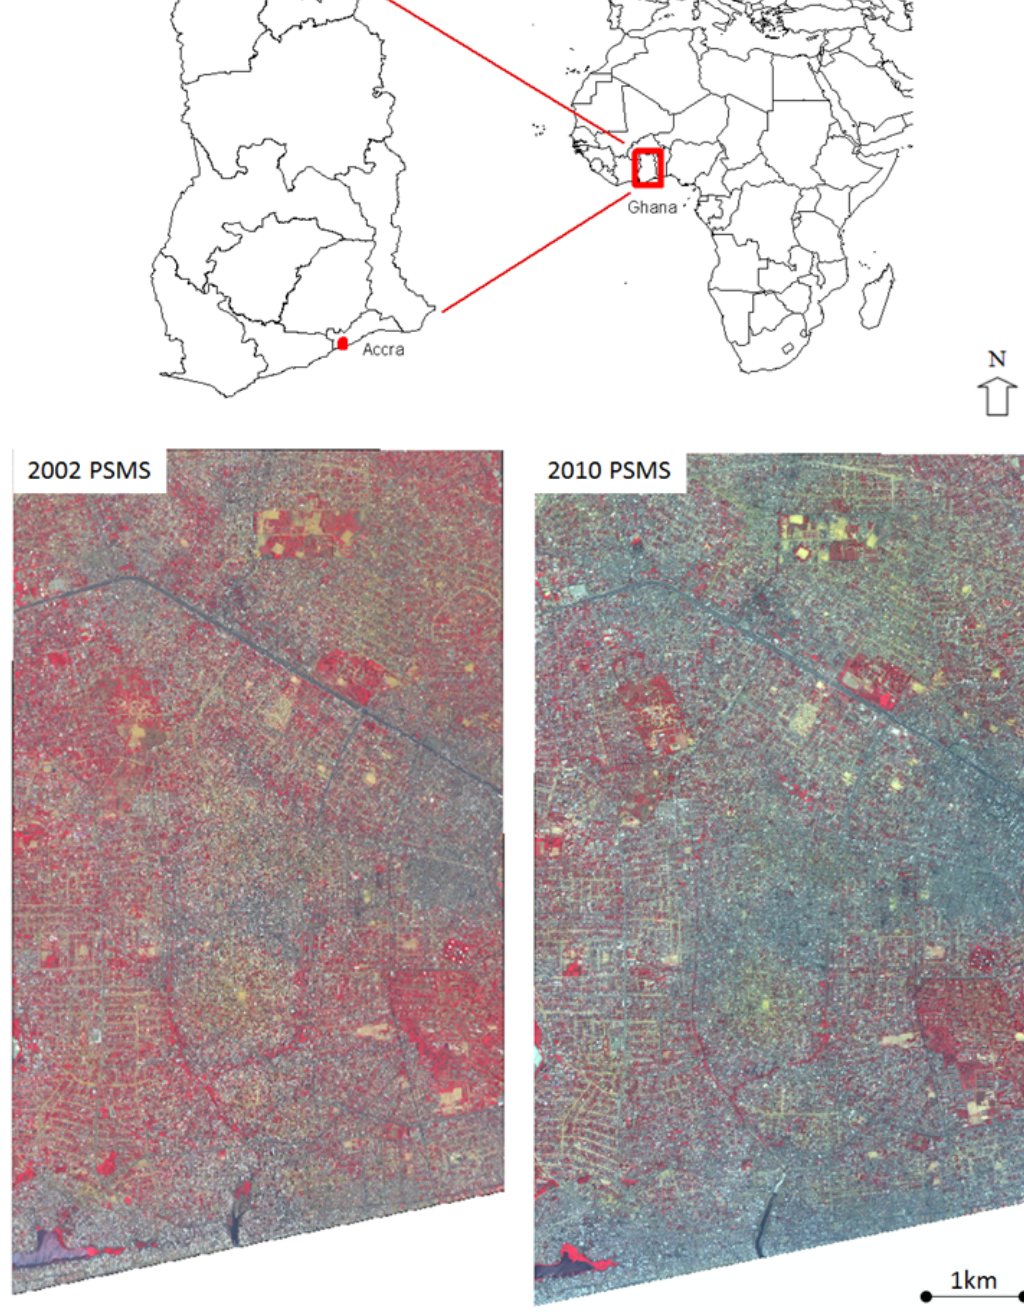
Figure 1. Map of Accra, Ghana. The study area for 2002 and 2010 QuickBird pan-sharpened multispectral images are displayed in standard false color infrared composite